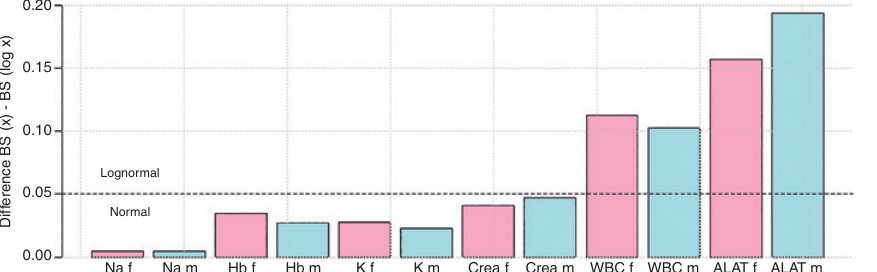
Figure 4: Improved criterion using the difference of Bowley’s skewness for original and log-transformed data. We chose a cut-off at 0.05 by visual inspection to ensure that Na, K, Hb and Crea come out as normal distributions across both